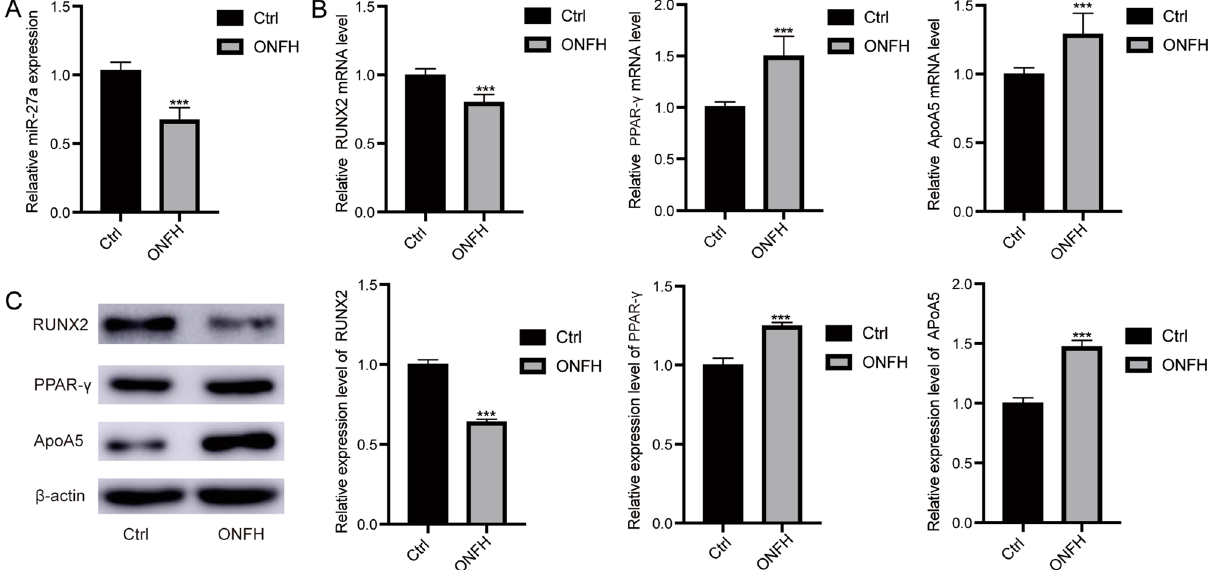
Figure 1. The levels of miR-27a, Runx2, PPAR-γ and ApoA5 in steroid-induced ONFH patients. ( A ) Comparison of miR-27a mRNA level between steroid-induced ONFH patients and controls. ( B ) Comparison of Runx2, PPAR-γ and ApoA5 mRNA level between steroid-induced ONFH patients and controls. ( C ) Protein expression of Runx2, PPAR-γ and ApoA5 between steroid-induced ONFH patients and controls. *** P <